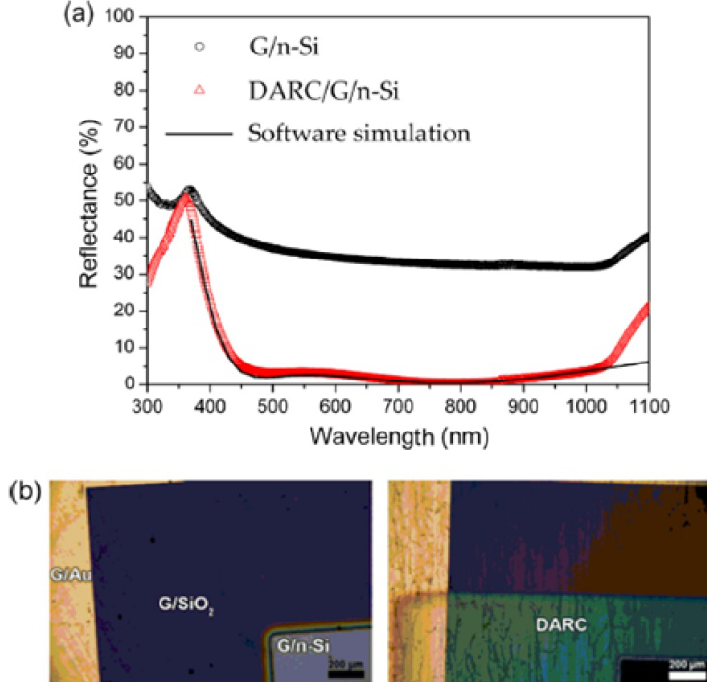
Fig. 2. (a) The spectra of light reflection observed on a G/n-Si structure prior (black circles), the Essential Macleod software modelling (red triangles) and the continuous line as after the DARC evaporation. (b) Microscopic images of a fraction on the front side of the device prior (left), the deposition of DARC (right). Reprinted with permission from L. Lancellotti, E. Bobeico, A. Capasso, E. Lago, P. D. Veneri and E. Leoni // Solar Energy 127 (2016)